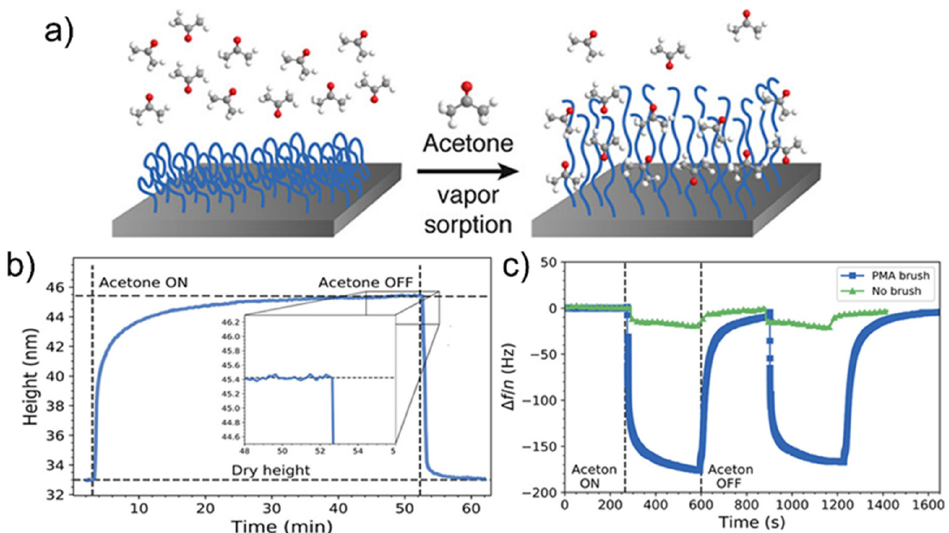
Figure 9. ( a ) Schematic picture of acetone sensing by brush PMA. ( b ) Swelling response of the dense brush after exposure to acetone vapor at t = 0 and to dry nitrogen gas at t = 53 min and ( c ) the measured change in oscillation frequency (fundamental) upon exposure to acetone vapor for a PMA brush versus a crystal with a brush as measured by quartz crystal microbalance. Adapted from Ref. [95].